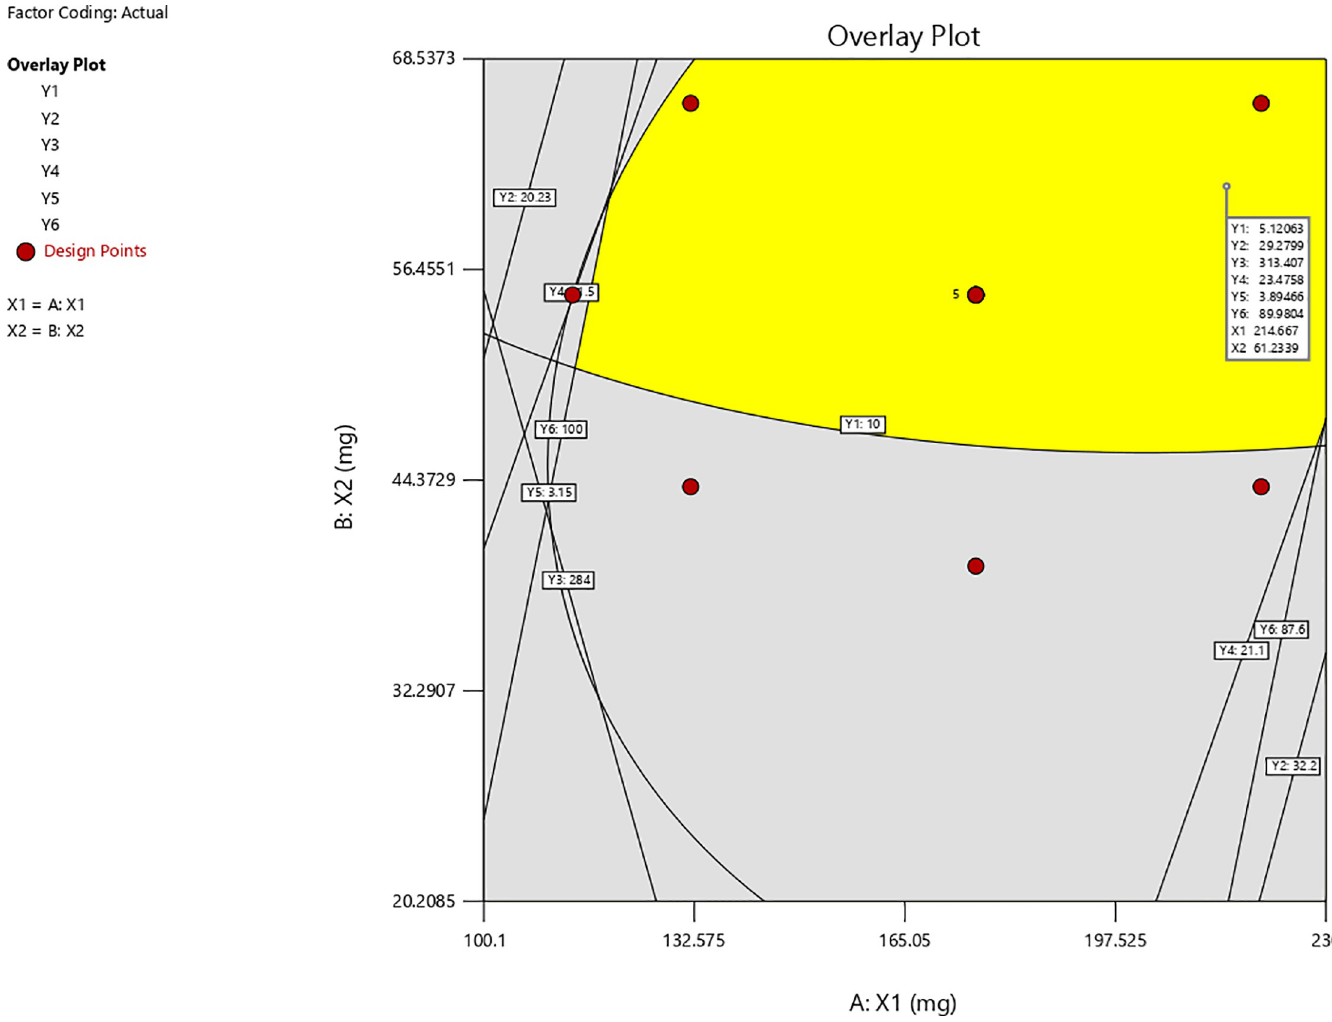
Fig 3. Overlay plot of optimized formulation of ranitidine HCl matrix